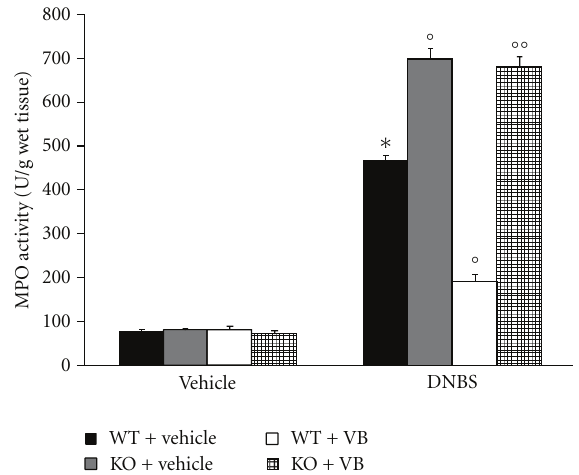
Figure 5: E ff ect of endogenous PPAR- α on neutrophil infiltration. Myeloperoxidase (MPO) activity was significantly increased in DNBS-treated PPAR- α WT mice in comparison to SHAM. MPO activity was significantly enhanced in DNBS-treated PPAR- α KO mice. Treatment with VB significantly reduced the colon MPO activity. The genetic absence of the PPAR- α receptor significantly blocked the e ff ect of VB treatment. Data are means ± SEM of 10 mice for each group. ∗ P < . 01 versus sham; ◦ P < . 01 versus DNBS